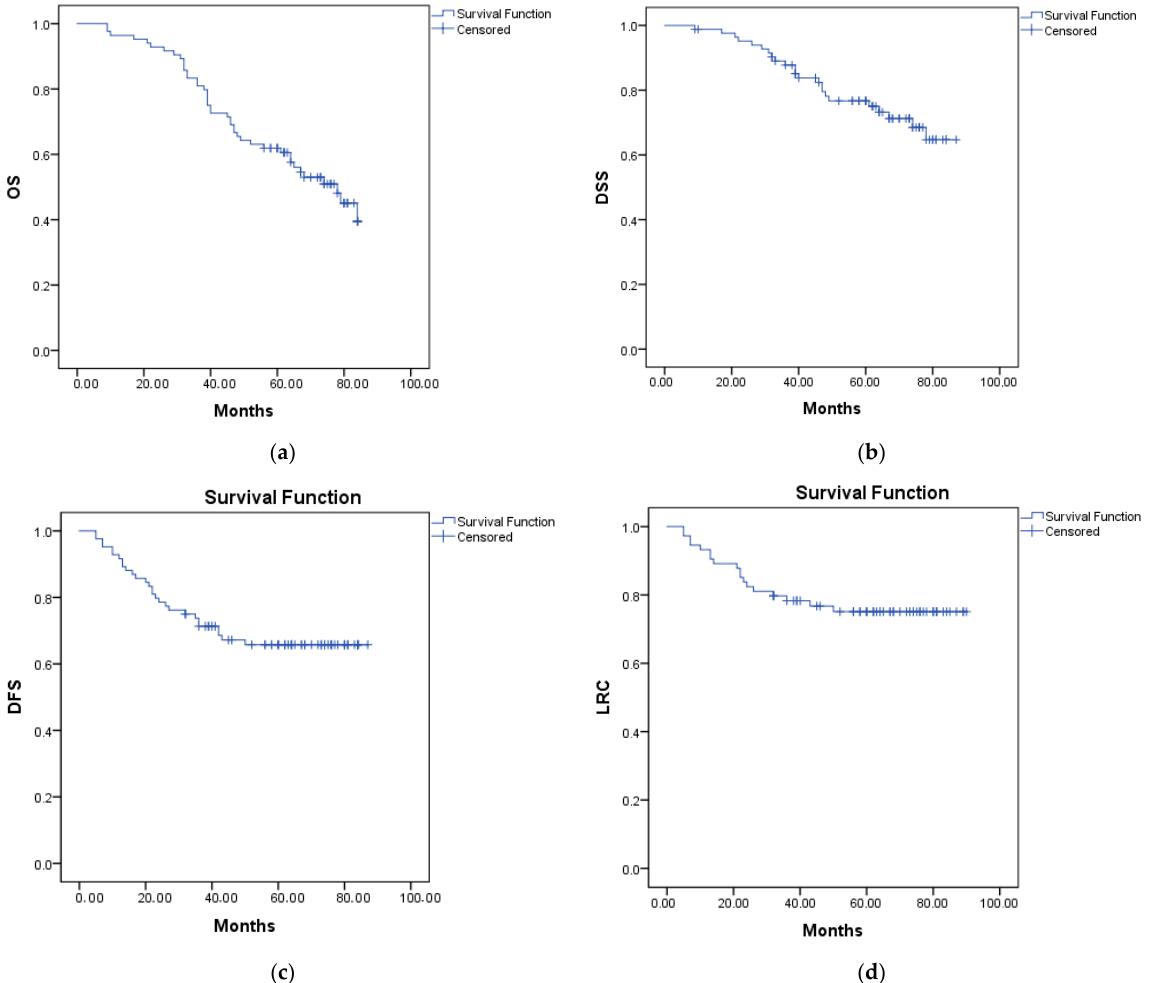
Figure 2. ( a ) Kaplan–Meier curve showing OS, median 78 months; ( b ) DSS, median NR; ( c ) DFS, median NR; ( d ) LRC, median NR. Table 3. Survival for different treatment